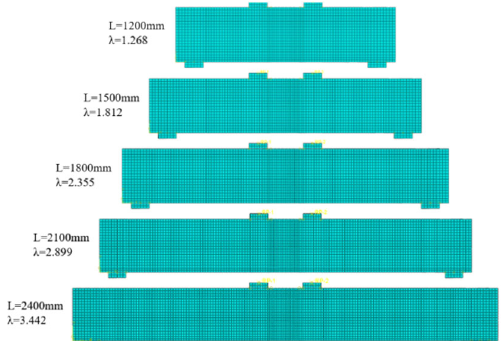
Figure 20. Schematic diagram of shear span ratio parameter group model.